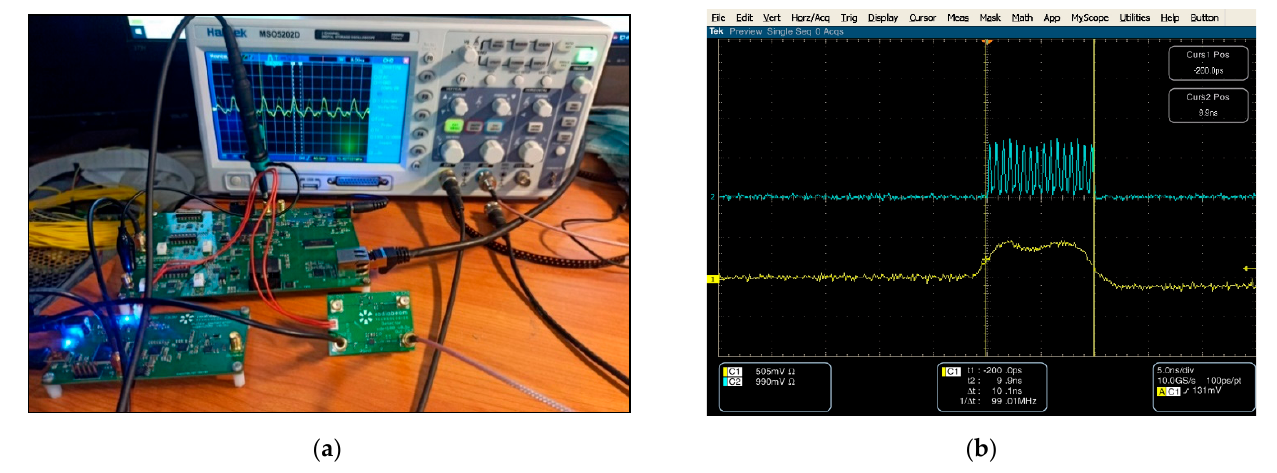
Figure 12. Pulse length measurement boards during the debugging ( a ) and the measured signal of a 10 ns-long pulse filled with a 1.6 GHz IF signal ( b ).